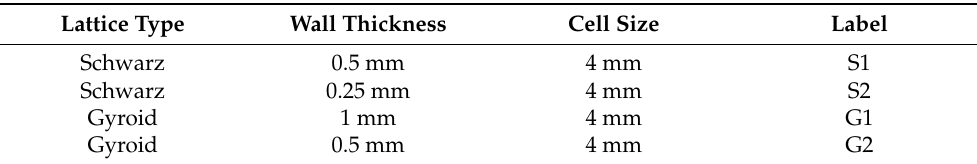
Table 2. The geometric parameters of TPMS samples.